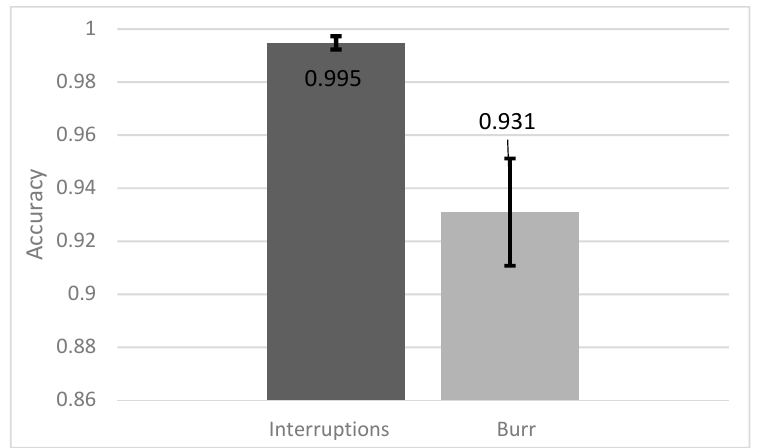
Figure 9. Comparison of the test accuracy between interruptions and burr formations.